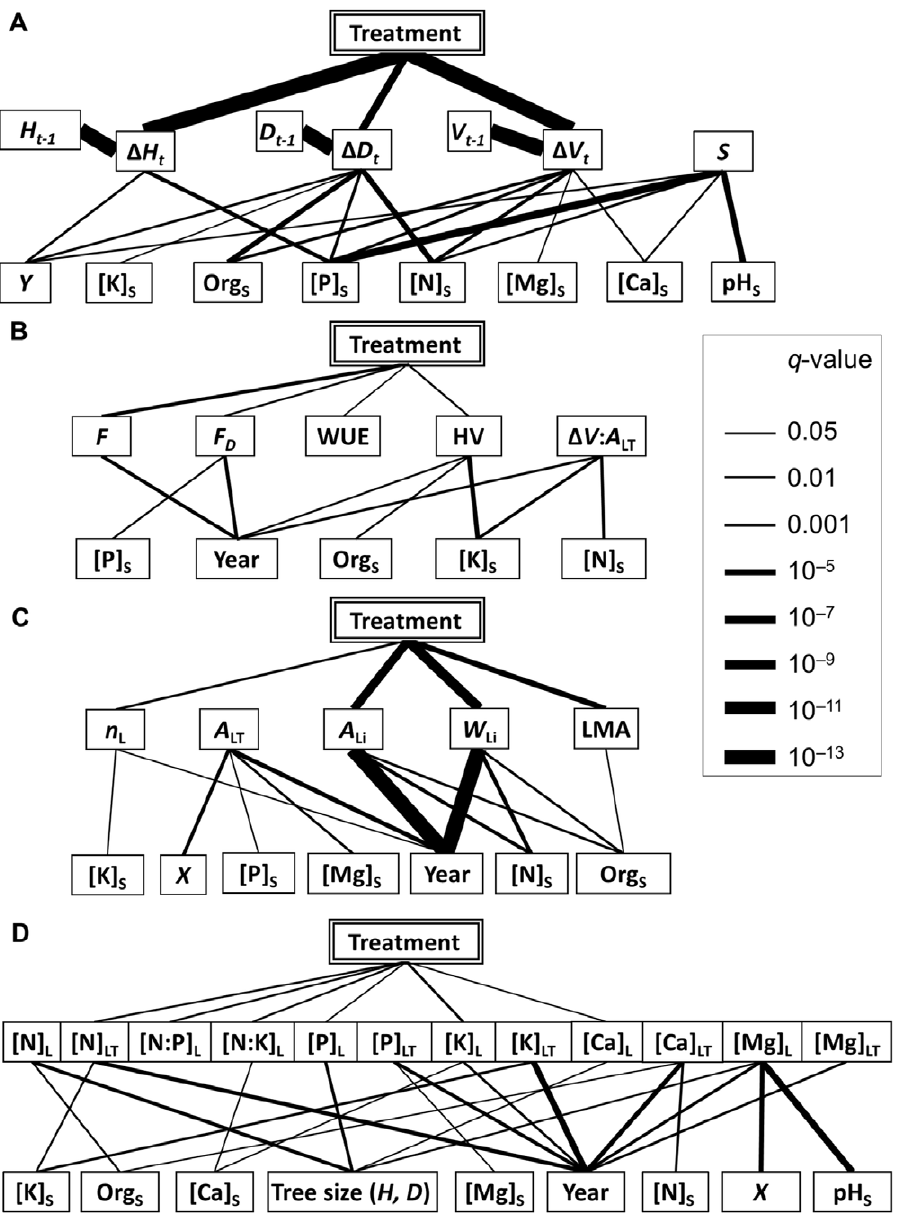
Figure 4. Graphical representation of the first-order relationships between treatment and confounding variables with a) tree growth, b) water use, c) leaf size and d) foliar chemistry characteristics. A solid line between two nodes denotes a significant ( q , 0.05) association between the variables, with the thickness of the line proportional to the statistical significance ( 2 log( q )).